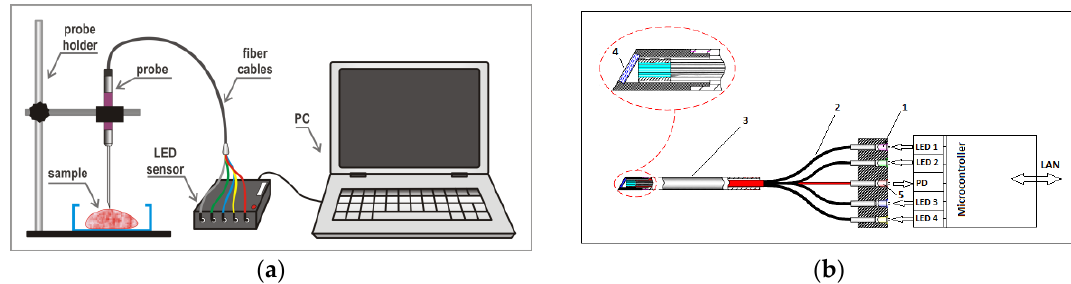
Figure 4. Probe construction and measurement setup. ( a ) Experimental setup, and ( b ) probe construction schematic: 1—light-emitting diodes (LEDs); 2—fiber cables; 3—stainless steel tube; 4—sapphire window (in Series A measurements, the probe tip had a right-angled shape and was not protected by a glass window); and 5—photodiode detector. (Reproduced with permission from authors [29]).